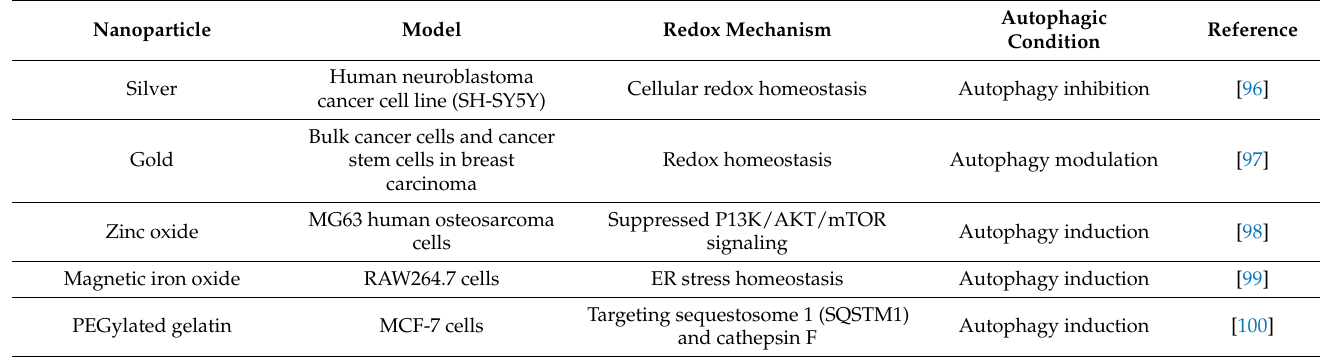
Table 3. Redox metabolism and autophagy as cancer targets for nanoparticle-mediated targeting in different